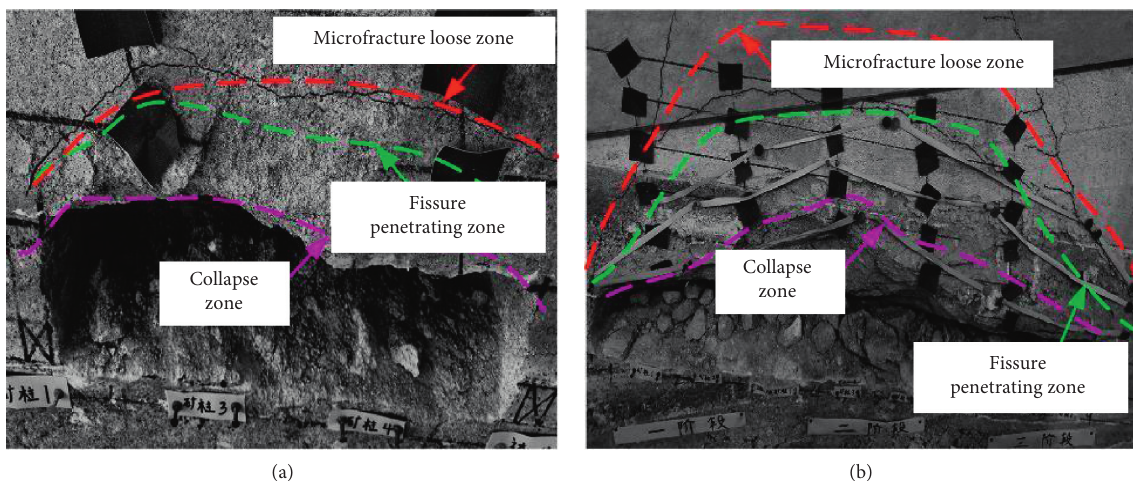
Figure 7: The failure characteristics of the overlying rock mass at the stage of recovering the pillars. (a) Recover pillar #3 and pillar #4; (b) recover the continuous pillar